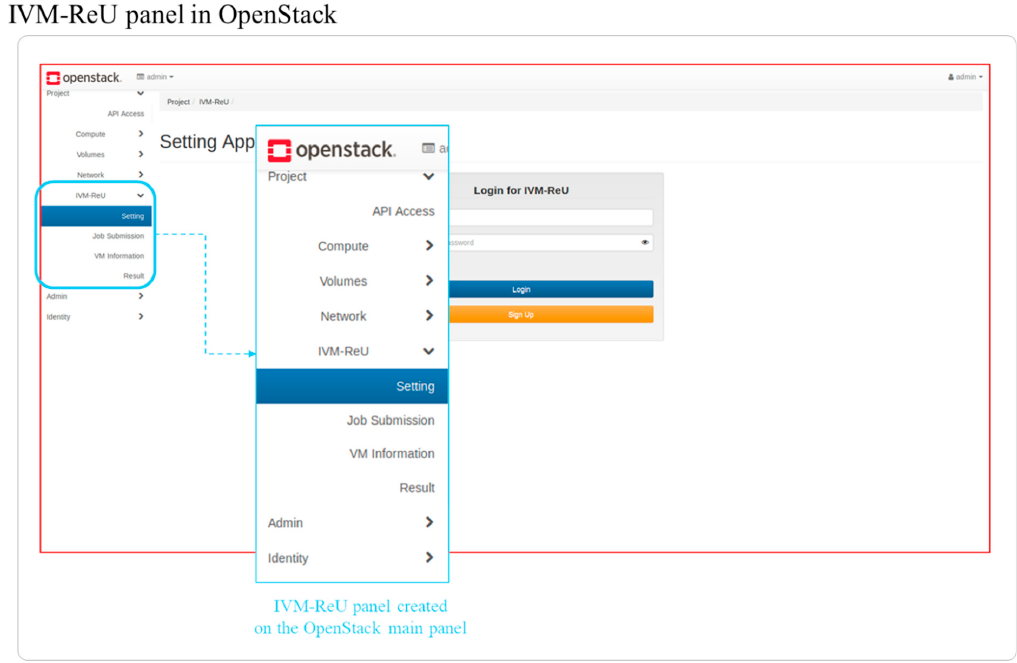
Figure 4. IVM–ReU panel in OpenStack.